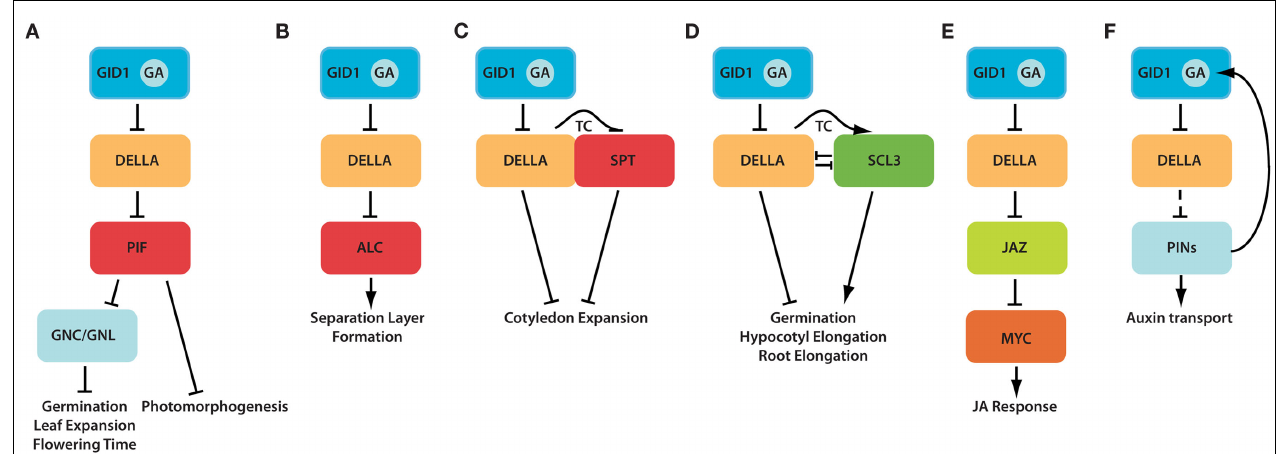
together repress cotyledon formation, thus SPT and DELLAs act in an analogous manner. DELLAs may also negatively control SPT transcription (transcriptional control,TC). (D) DELLAs also interact with the GRAS-family protein SCL3. DELLAs and SCL3 regulate each other in an antagonistic manner and have opposing effects on the biological processes that they control. (E) JAZ proteins have emerged as central repressors of JA signaling.Their activity is on the one side negatively controlled by DELLA interaction and on the other side by jasmonates (JA). JAZ proteins are repressors of MYC transcription factors. (F) DELLAs indirectly regulate the abundance of PIN proteins and thereby influence auxin transport and auxin transport-dependent development. Auxin (transport) positively feeds back on GA